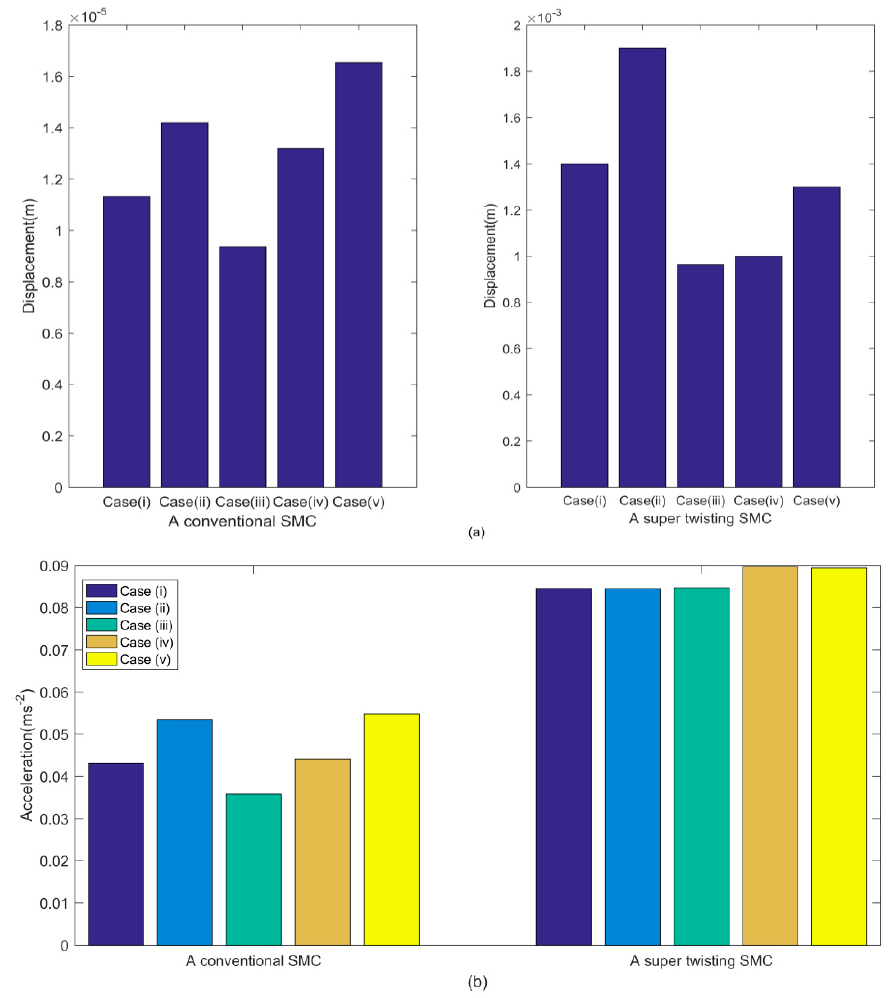
Figure 6. RMS values of the responses with the conventional sliding mode control (SMC) and the super-twisting SMC for five cases (( a ) displacements, ( b ) accelerations).